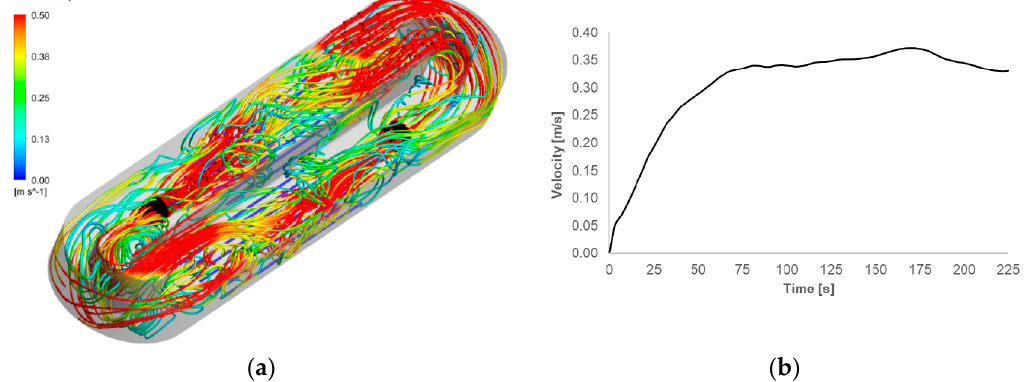
Figure 5. Water velocity streamlines ( a ) and average water velocity plot ( b ).